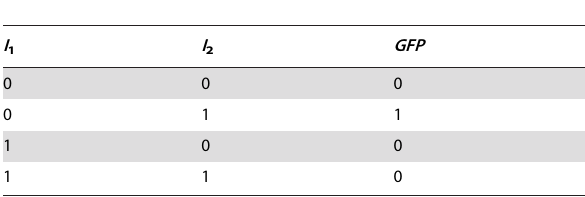
Table 1. Truth table for a NI 1 Boolean function.